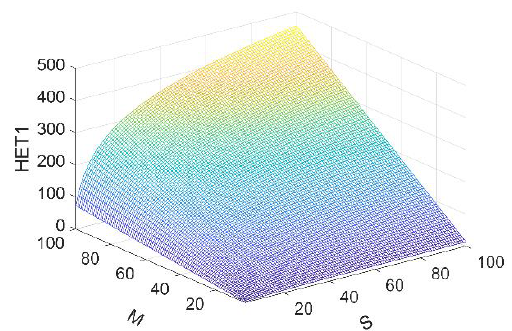
Figure 4. HET1 max of the mimic control plane.